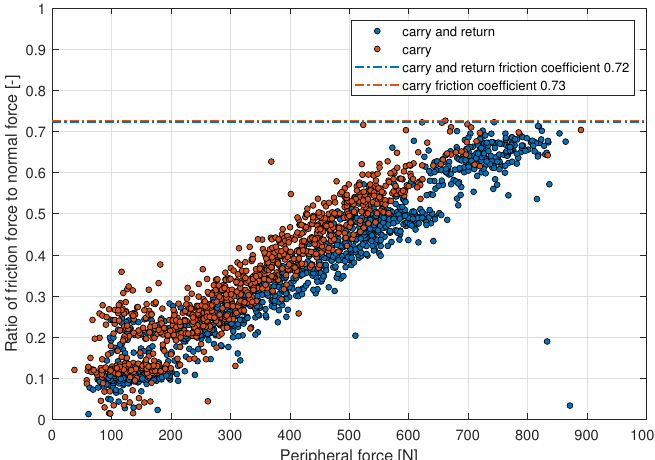
Figure 11. Ratio of friction force to normal force as a function of intermediate drive peripheral force for two work variants.